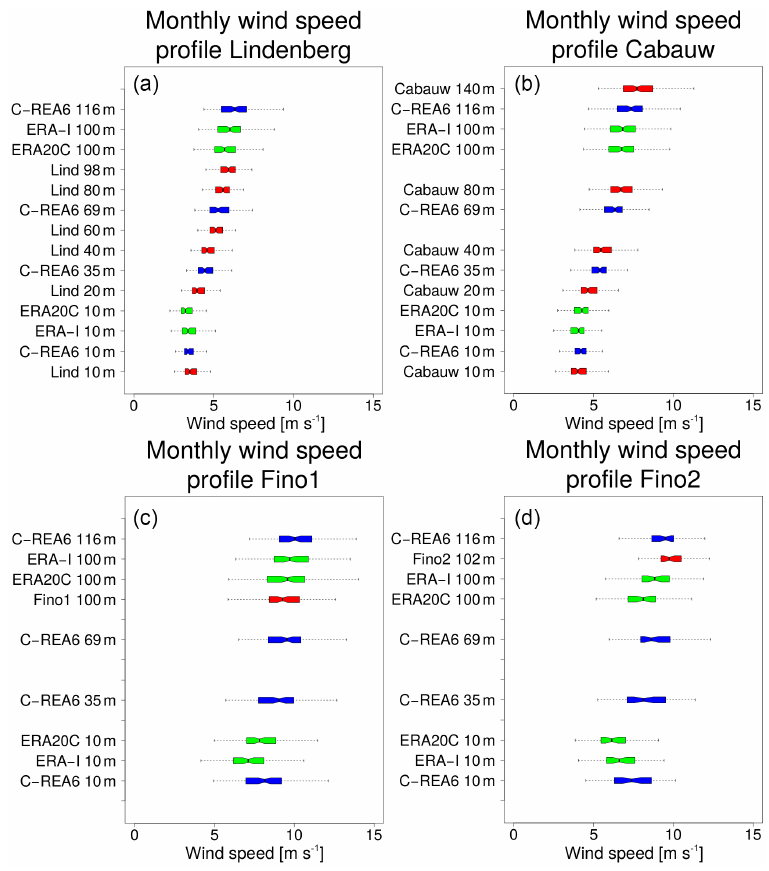
Figure 1. Box plots of monthly mean wind speed at Lindenberg (top left), Cabauw (top right), FINO1 (bottom left), and FINO2 (bottom right) at different heights between 10 and around 100m. Mast measurements are shown in red, regional reanalysis data (COSMO-REA6) in blue, and global reanalysis data (ERA-Interim and ERA20C) in